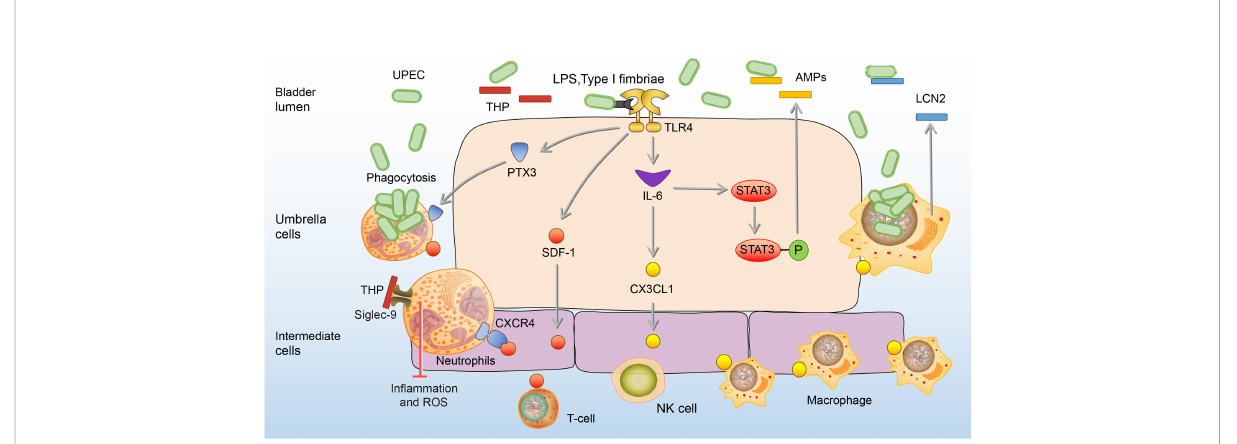
FIGURE 1 Extracellular immune responses to UPEC in the bladder. At the beginning of infection, THP reduces the adhesion of UPEC to the BECs. In addition, the THP can prevent excessive in fl ammation and ROS production of neutrophils. Once adhesion, BECs secrete SDF-1, PTX3, and IL-6. SDF-1 recruit neutrophils, T-cells, and NK cells to the site of infection. PTX3 promotes neutrophils to engulf UPEC, and IL-6 promotes the expression of CX3CL1 to recruit macrophages which kill UPEC by phagocytosis and LCN2. IL-6 also enhances the release of AMPs through phosphorylation of Stat3.AMPs, antimicrobial peptides; BEC, bladder epithelial cells; CXCR4, CXC-motif chemokine receptor 4; CX3CL1, C-X3-C motif chemokine 1; LCN2, lipocalin-2; IL-6, interleukin 6; NK cells, natural killer cells; PTX3, Pentraxins; SDF-1, stromal cell-derived factor1; Siglec-9, sialic acid-binding Ig-like lectin-9; Stat3, signal transducers and activators of transcription 3; THP, Tamm-Horsfall protein; UPEC, Uropathogenic Escherichia coli